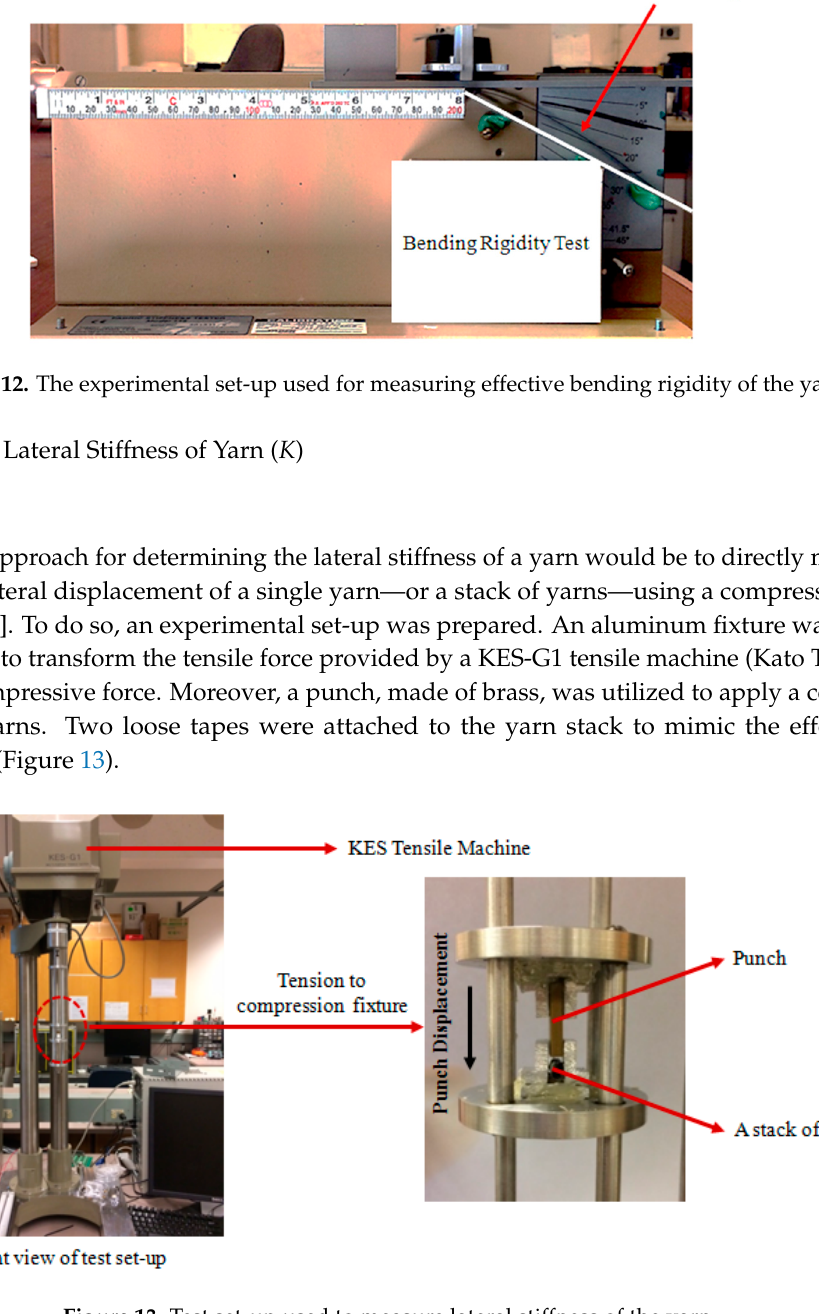
Figure 13. Test set-up used to measure lateral stiffness of the yarn.